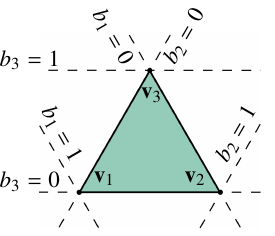
Figure 4. Barycentric coordinates b